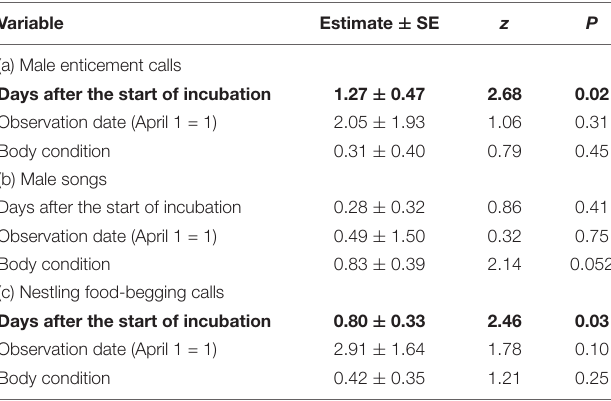
TABLE 2 | Separate multivariable GLM with a Poisson error distribution predicting the number of male responses to the experimental playback of male enticement calls (a), male songs (b) and nestling food-begging calls (c), respectively ( n male = 17